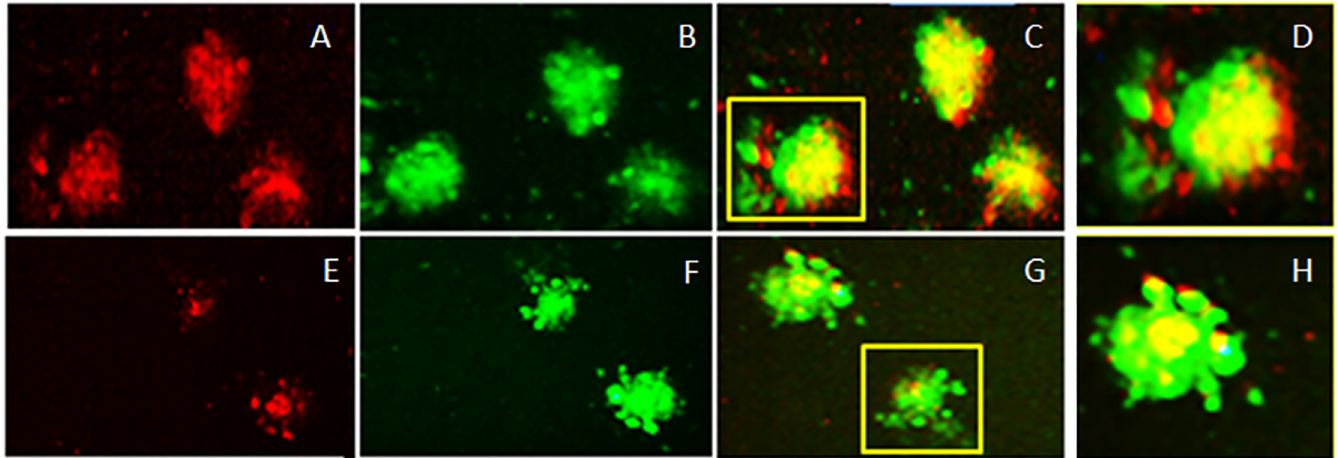
Fig 6. Embryoid bodies/mTreg derived from rat MSCs express CCR8 and FoxP3. CCR8 (6A, red) and FoxP3 (6B, green) co-localize (6C, yellow; 10x mag and 6D, 20X mag). This expression of CCR8 is inhibited by a monoclonal antibody against CCL1 ( > CCL1) [6E-G; 10Xmag; H,20X